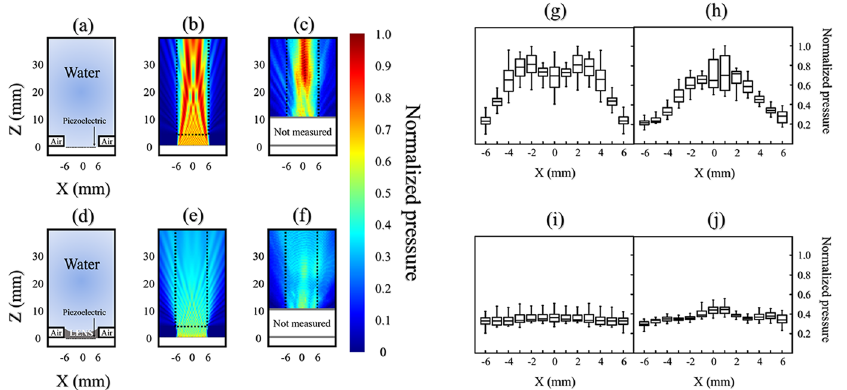
Figure 2. The acoustic pressure fields under either with or without the acoustic lens. Acoustic field propagations without (top) and with (bottom) the concave-shaped acoustic lens. ( a ) Schematic of the measured domain without the lens. ( b ) Simulated and ( c ) measured results of the pressure field without the lens. ( d ) Schematic of the measured domain with the lens. ( e ) Simulated and ( f ) measured results of the pressure